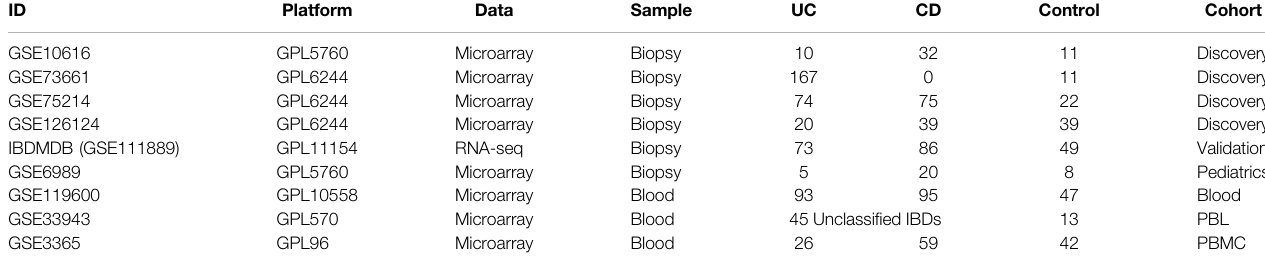
TABLE 3 | The brief descriptions of the inclusive data series.